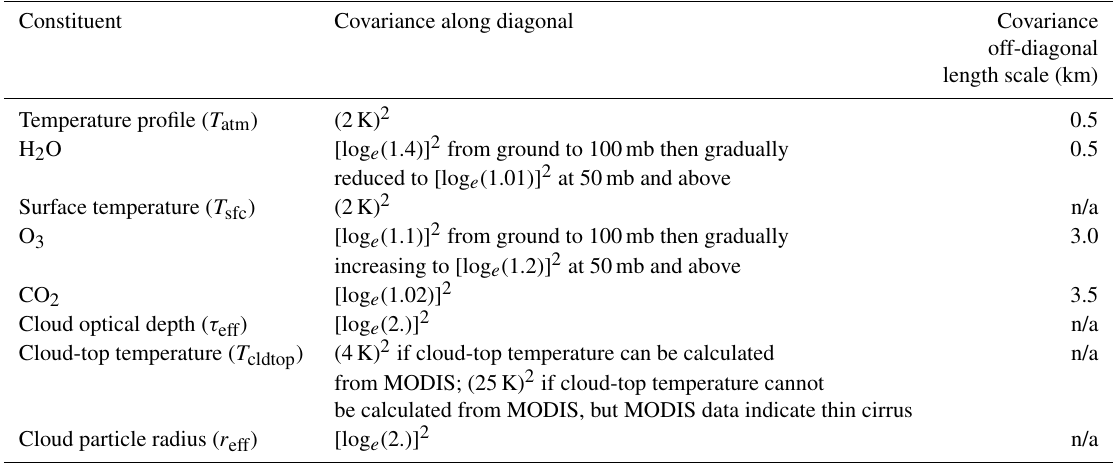
off-diagonal length scale (km)